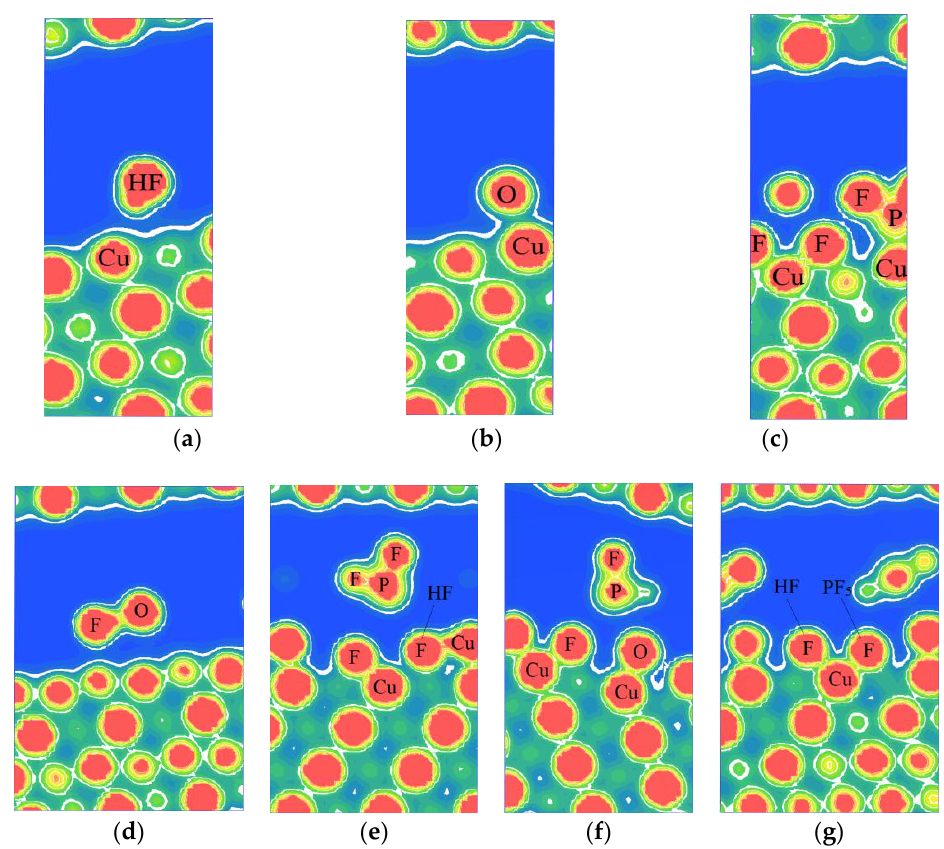
Figure 3. The electron density plots of the stable configurations of HF, H 2 O, and PF 5 adsorbed on Cu(111) surface: ( a ) HF, ( b ) H 2 O, ( c ) PF 5 , ( d ) HF and H 2 O, ( e ) HF and PF 5 , ( f ) H 2 O and PF 5 , and ( g ) HF, H 2 O, and PF 5 .